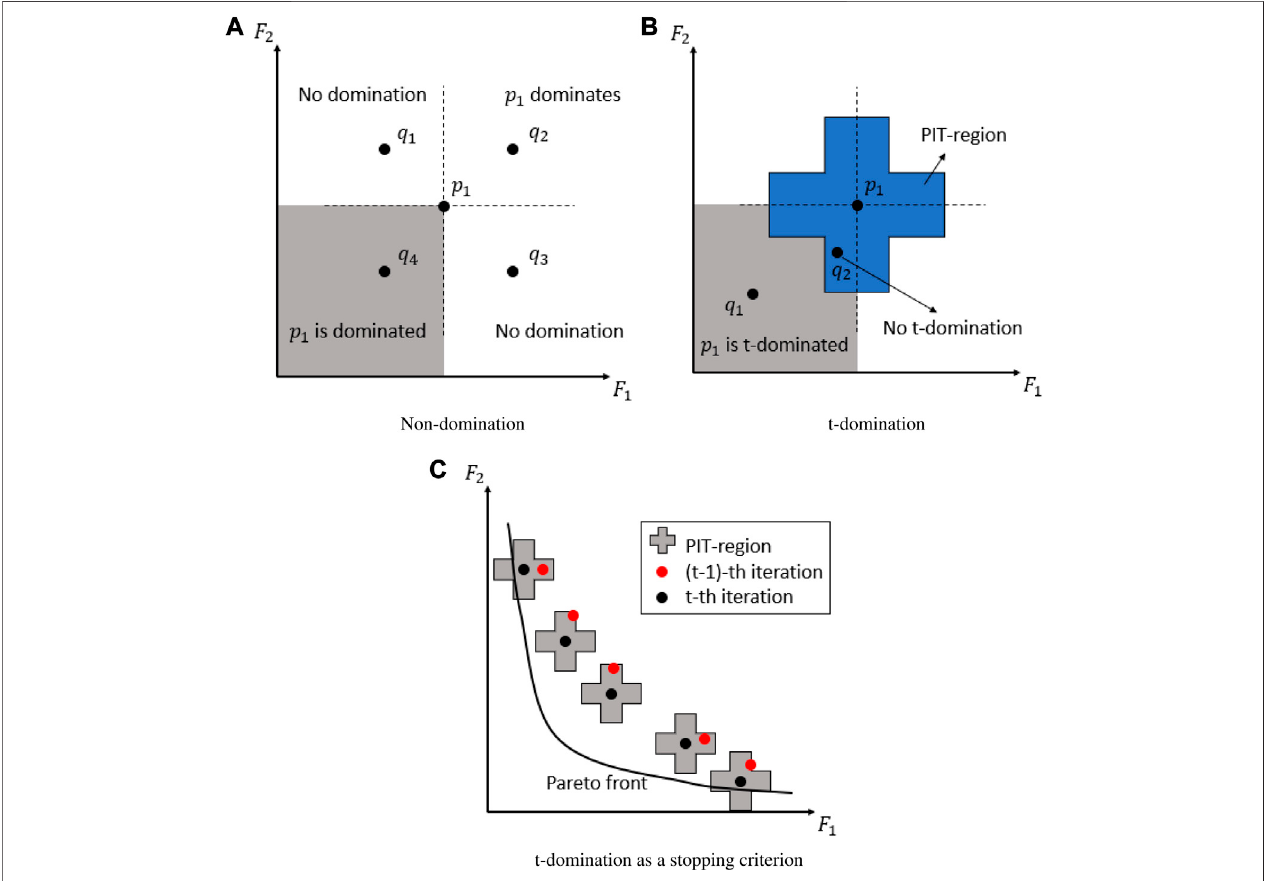
FIGURE 4 | Graphical representation of non-domination (A) , t-domination (B) and t-domination as a stopping criterion (C) in case of a bi-objective problem.